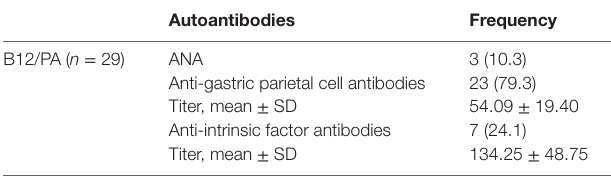
The levels of different panels of disease-related autoantibodies were tested in the individual recruited for this study according to validated guidelines. The frequency of the autoantibodies was indicated as n (%) referred to the total of patients for each disease. The titers of some autoantibodies were expressed as mean ± SD or n (%) among patients positive for the corresponding